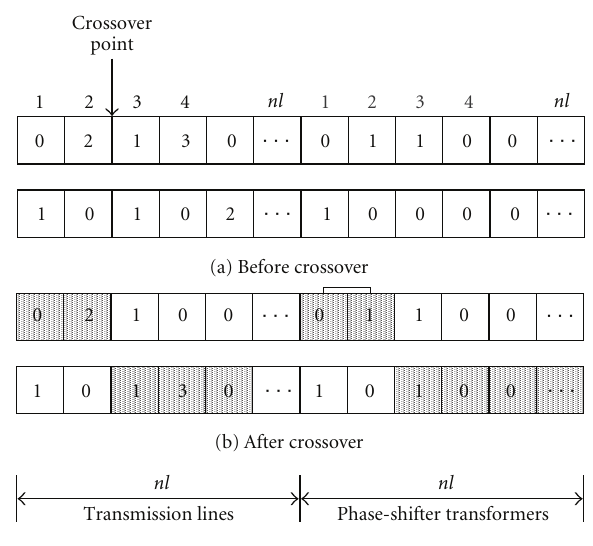
Figure 6: Single point